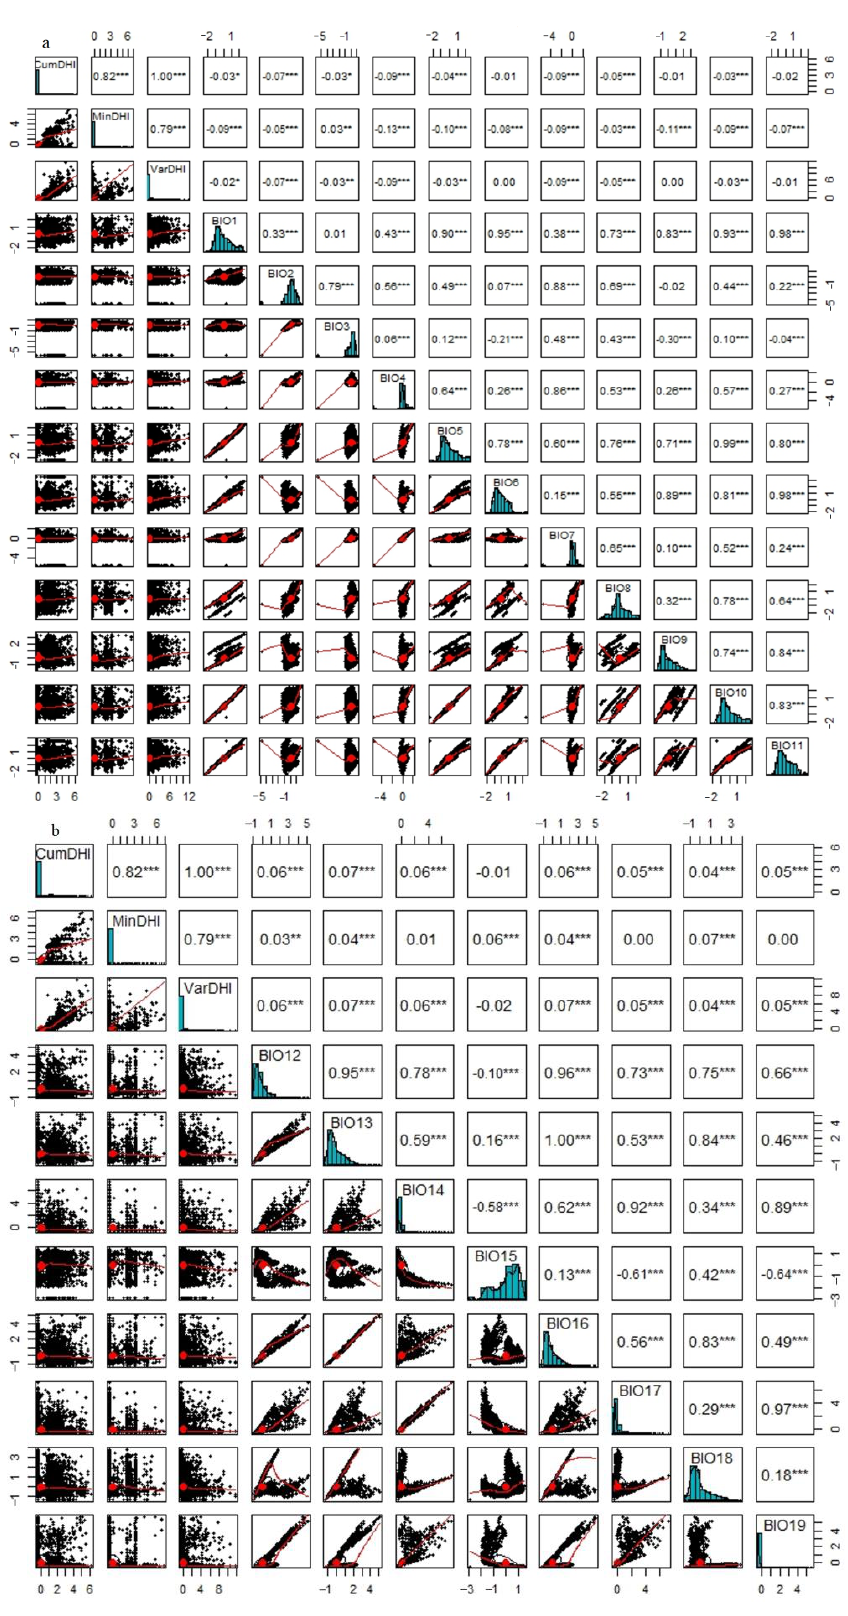
Figure 4. Pairs of the Spearman correlations of all MODIS FPAR-based DHIs versus the environmental variables grouped by ( a ) DHIs and temperature variables from Bioclim and ( b ) DHIs and precipitation values from Bioclim. Significant relations: * p < 0.05; ** p < 0.01; *** p < 0.001.